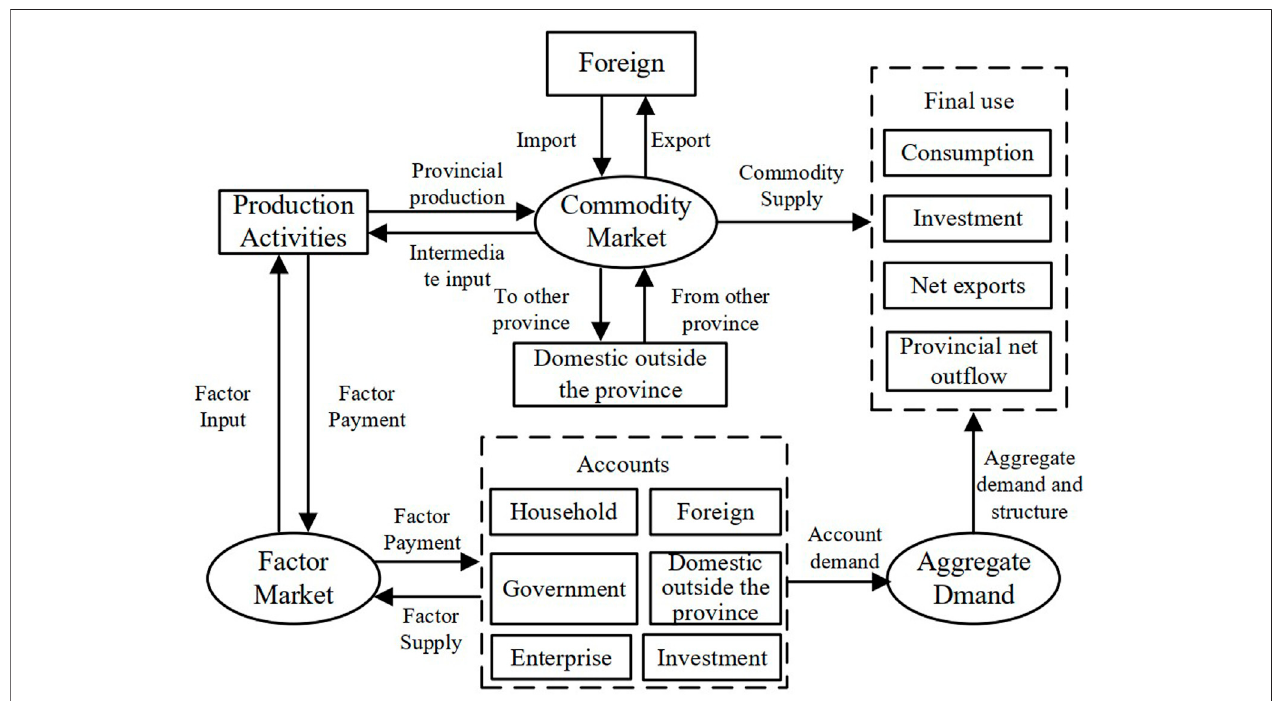
FIGURE 1 | Provincial CGE model